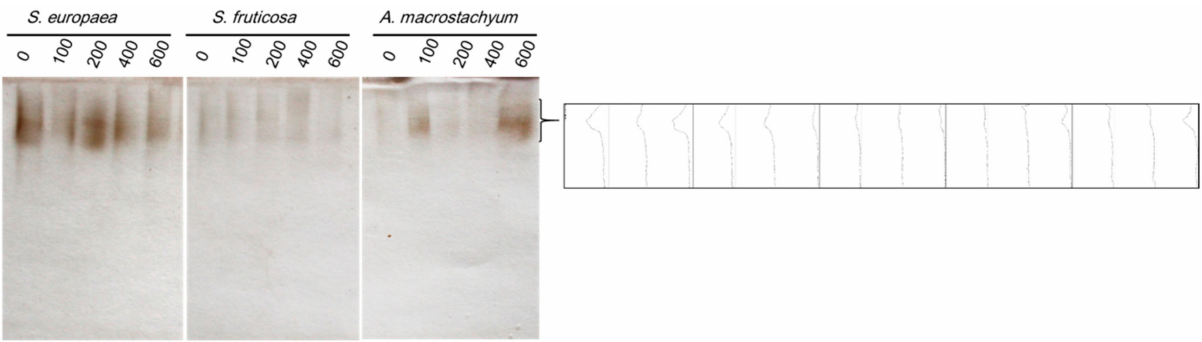
Figure 14. Peroxidase isozymes of S. europaea, S. fruticosa and A. macrostachyum under different NaCl concentrations. Pearson correlation and principal component